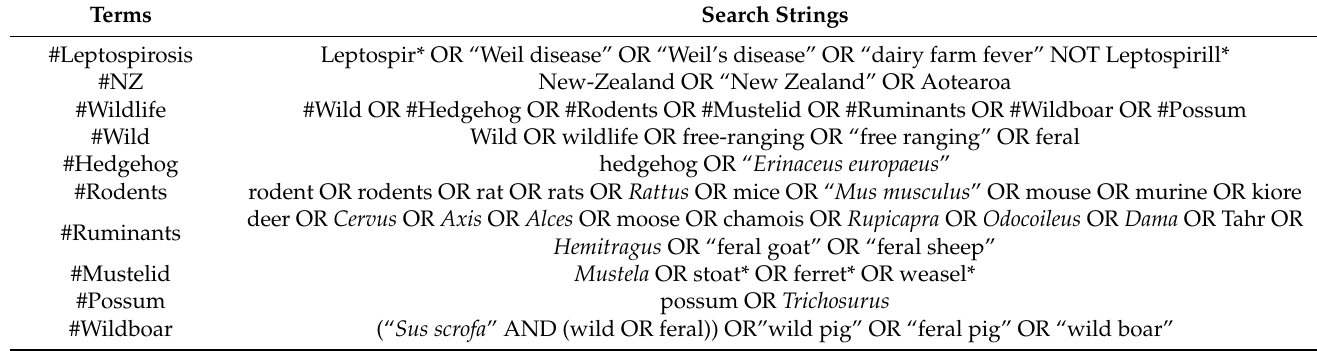
Table A1. Electronic search strategy used for Web Of Science, with detail on the search strings used (#Leptospirosis AND #NZ AND #Wildlife) to identify the wild maintenance hosts of Leptospira borgpetersenii serovar Ballum in New Zealand to include in the literature